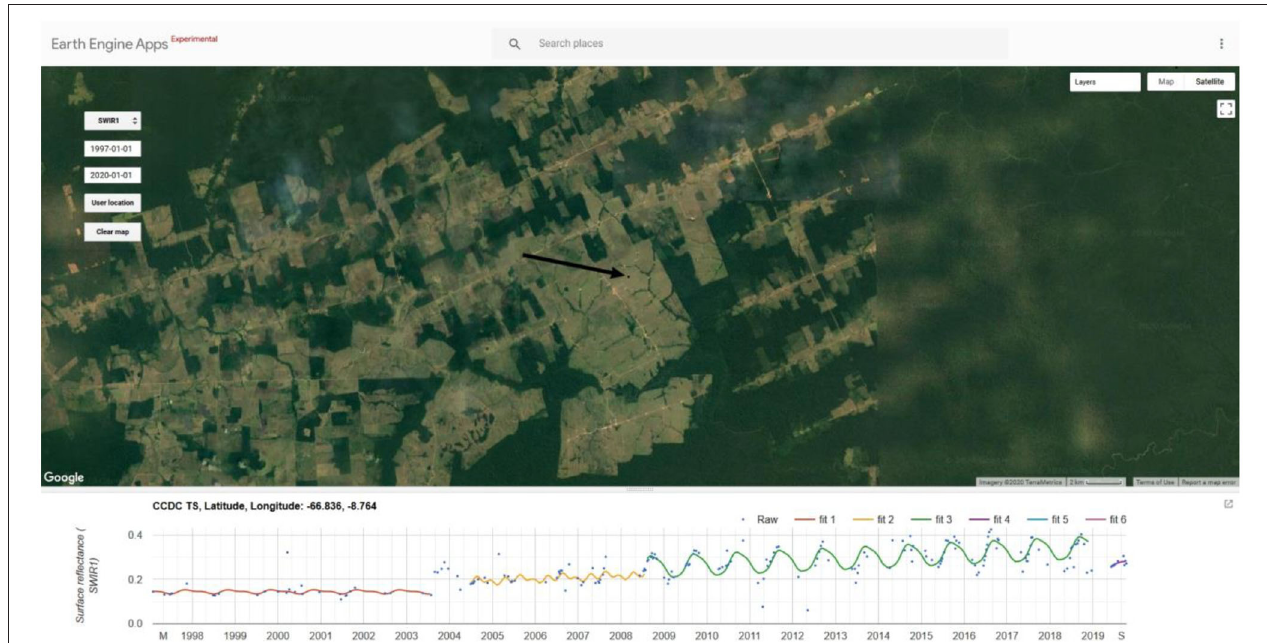
FIGURE 3 | Screenshot of the Simple viewer tool displaying time series of Landsat observations (blue dots) for a given pixel (black arrow) and the associated time segments (“fit” lines) as detected by the CCDC algorithm. The time series captures a deforestation event in western Brazil in 2004 for that pixel and the surrounding areas, followed by the establishment of croplands.